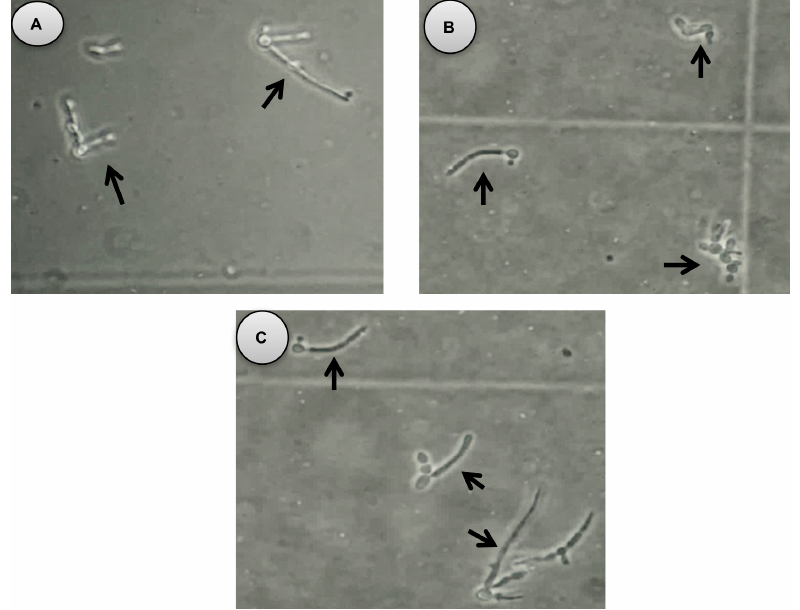
Figure 2. Germ tube growth after two hours of activation with fetal bovine serum with addition of ( A ) Control without essential oil; ( B ) Essential oil at a concentration of 8.0 mg/mL, which resulted in a decreased ability of the yeast to develop a germ tube; ( C ) Essential oil at a concentration of 0.5 mg/mL, with many yeast having normal germ tube growth, but some having poor growth. Arrows indicate the germ tube growth. Microphotographs were taken at 40×.